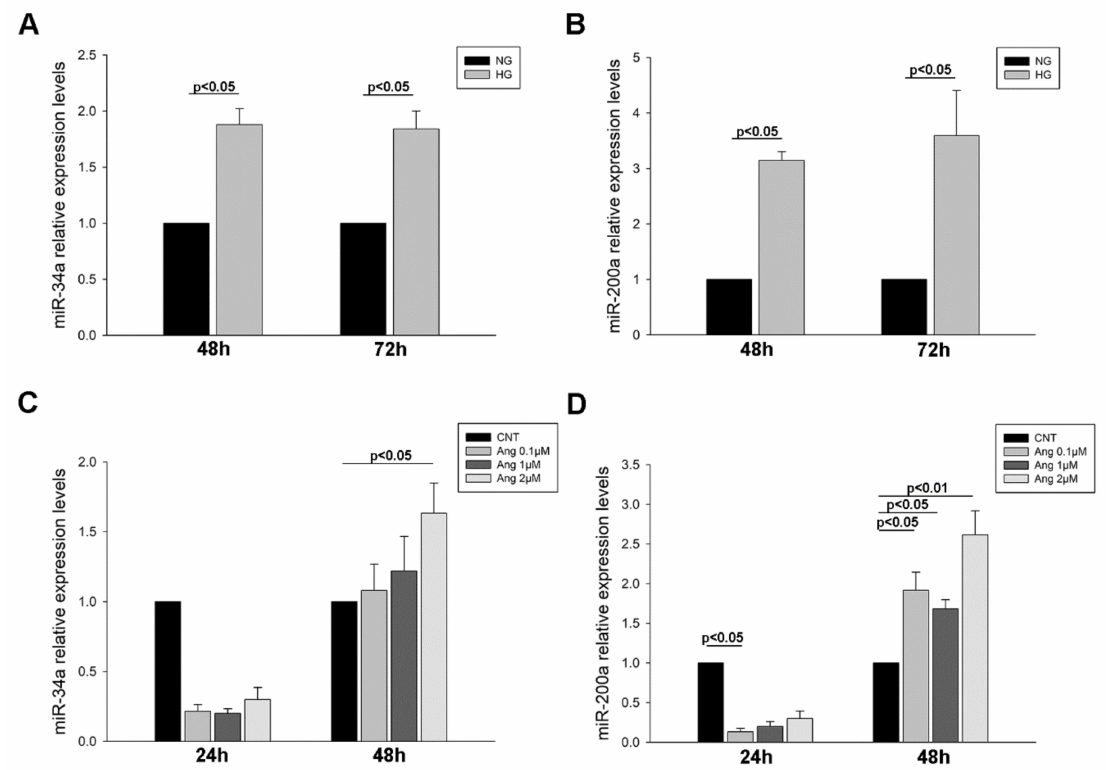
Figure 4. miRNAs levels in podocyte cultures subjected to HG and Ang II treatments. ( A ) Bar graphs of the comparison of miR-34a levels between NG and HG treated podocytes; ( B ) Bar graphs of the comparison of miR-200a levels between NG and HG treated podocytes; ( C ) Bar graphs of the comparison of miR-34a levels between Ang increasing concentrations; ( D ) Bar graphs of the comparison of miR-200a levels between Ang increasing concentrations. Bars represent mean ± SEM ( n = 6 each group). miRNA levels were normalised to two housekeeping miRNAs and relative expression was expressed in fold change with CNT group values set to 1-fold. NG: normal glucose; HG: high glucose; CNT: control; Ang: angiotensin